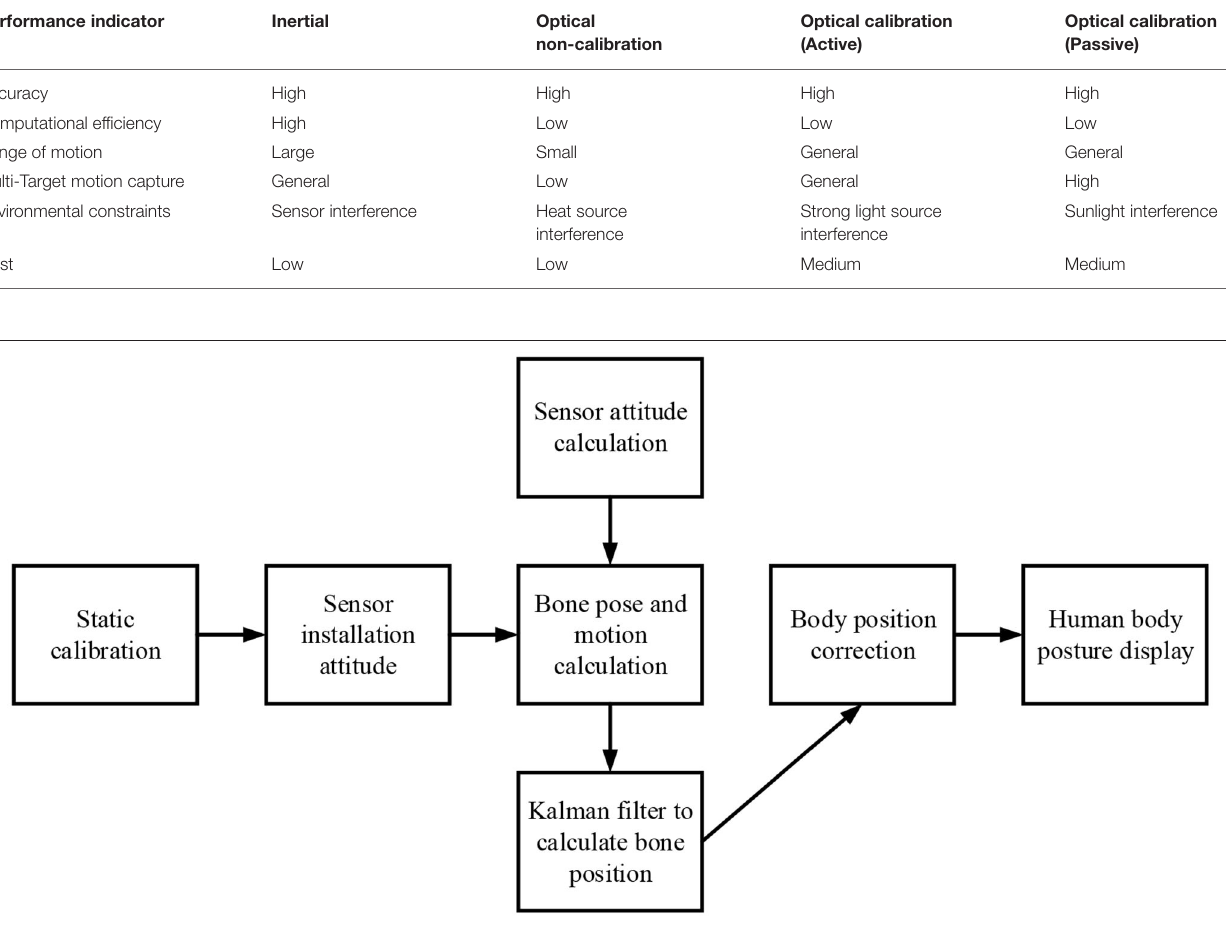
TABLE 1 | Performance comparison of different motion capture technologies.